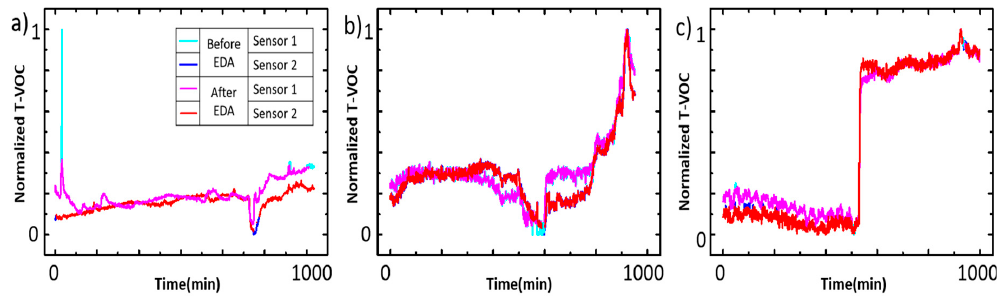
Figure 7. Analysis results in normalized scale. ( a ) CONSTANT, ( b ) EVENT 1, ( c ) EVENT 2.